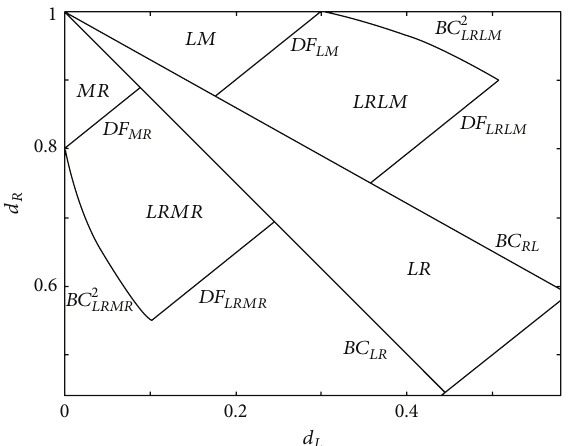
Figure 9: The 2⋅1 -fins 𝑃 𝑀𝑅 and 𝑃 𝐿𝑀 , and 2⋅2 -fins 𝑃 𝐿𝑅𝑀𝑅 and 𝑃 𝐿𝑅𝐿𝑀 , contiguous to the trunk regions 𝑃 𝐿𝑅 . Here 𝑎 𝐿 = 0.7 , 𝑎 𝑅 = 0.8 as in Figure